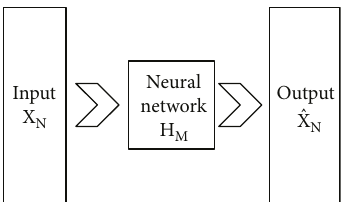
Figure 1: Schematic illustration of autoencoder neural